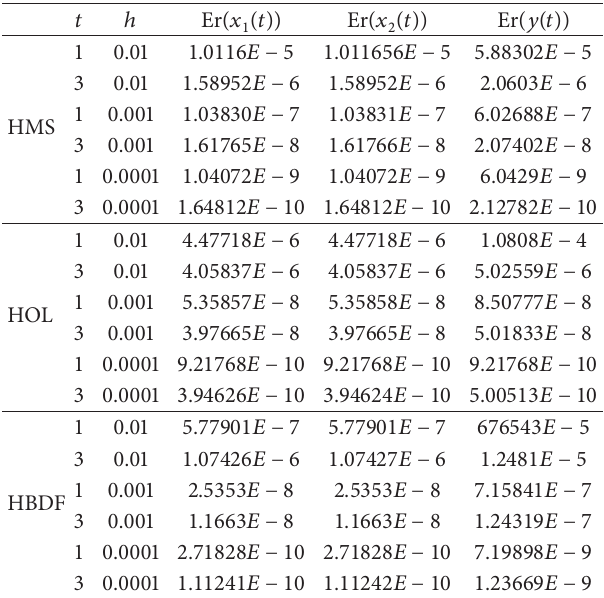
Table 3: The errors of solutions for the third